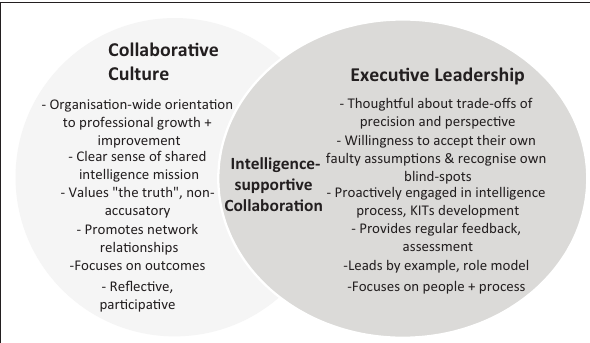
FIGURE 1: Collaboration as part of an intelligence-conducive work